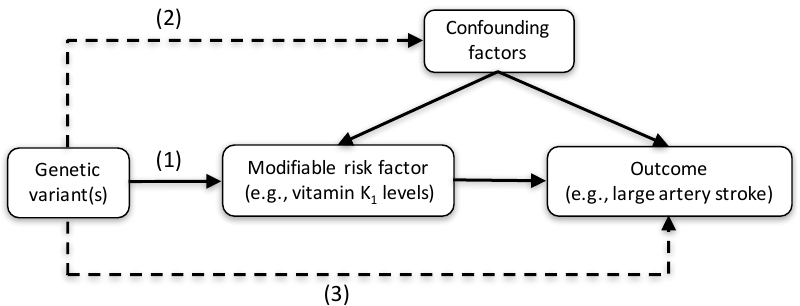
Figure 1. Concept of a Mendelian randomization (MR) study. A genetic variant (or multiple genetic variants in combination) associated with a modifiable risk factor, such as circulating vitamin K levels, can be used as an instrumental variable to determine the association between the risk factor and the outcome. The genetic variant used as an instrumental variable must (1) be robustly associated with the risk factor under study, (2) not be associated with any confounding factors of the risk factor-outcome relationship, and (3) affect the outcome through the risk factor under study and not through any other causal pathway. The dashed lines represent potential associations between variables that would represent violations of the Mendelian randomization assumptions.